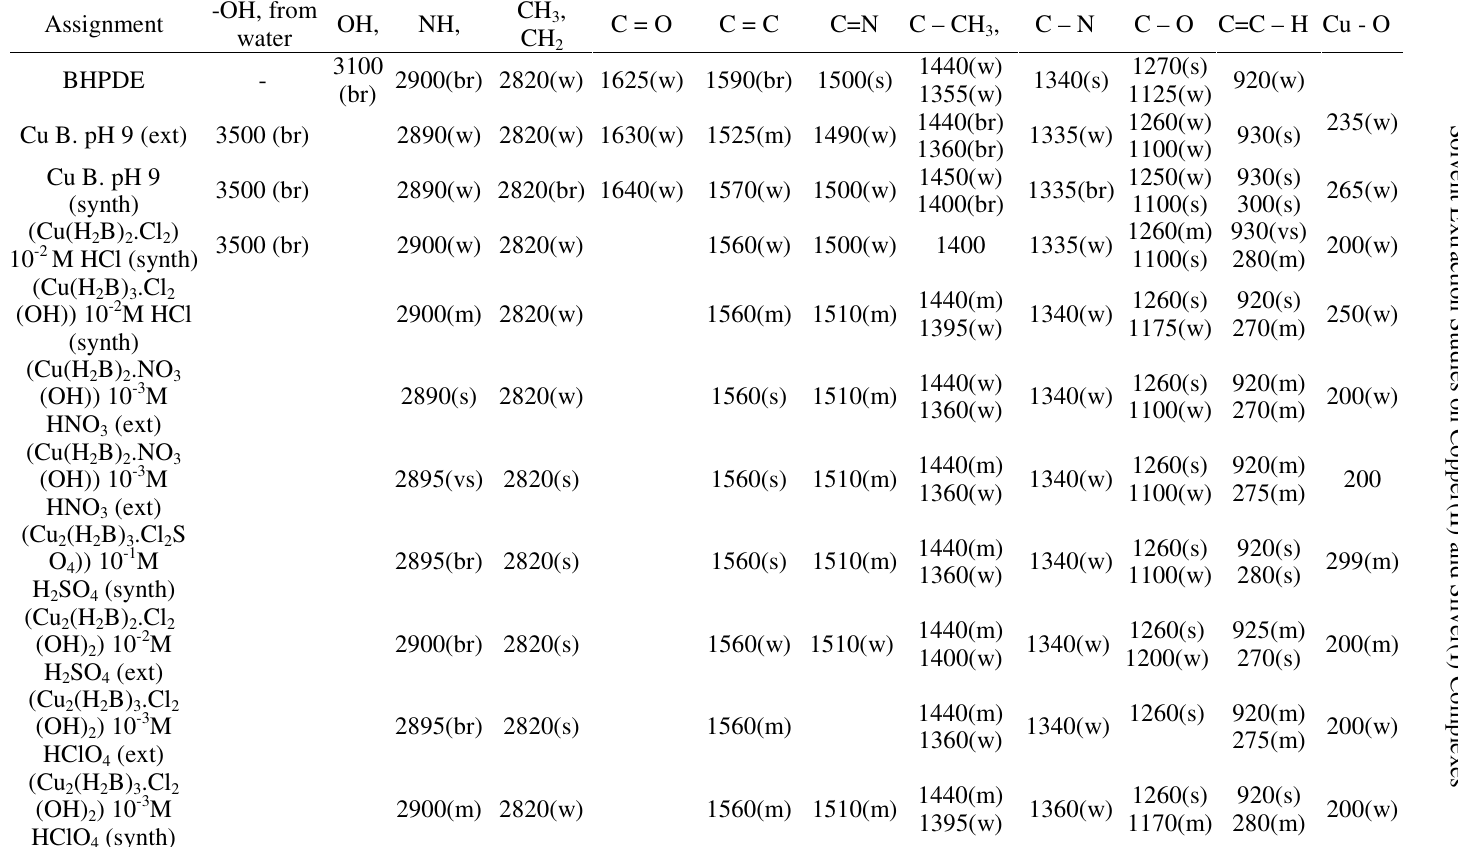
Table 4. Infrared Absorption Bands (cm -1 ) of Nujol